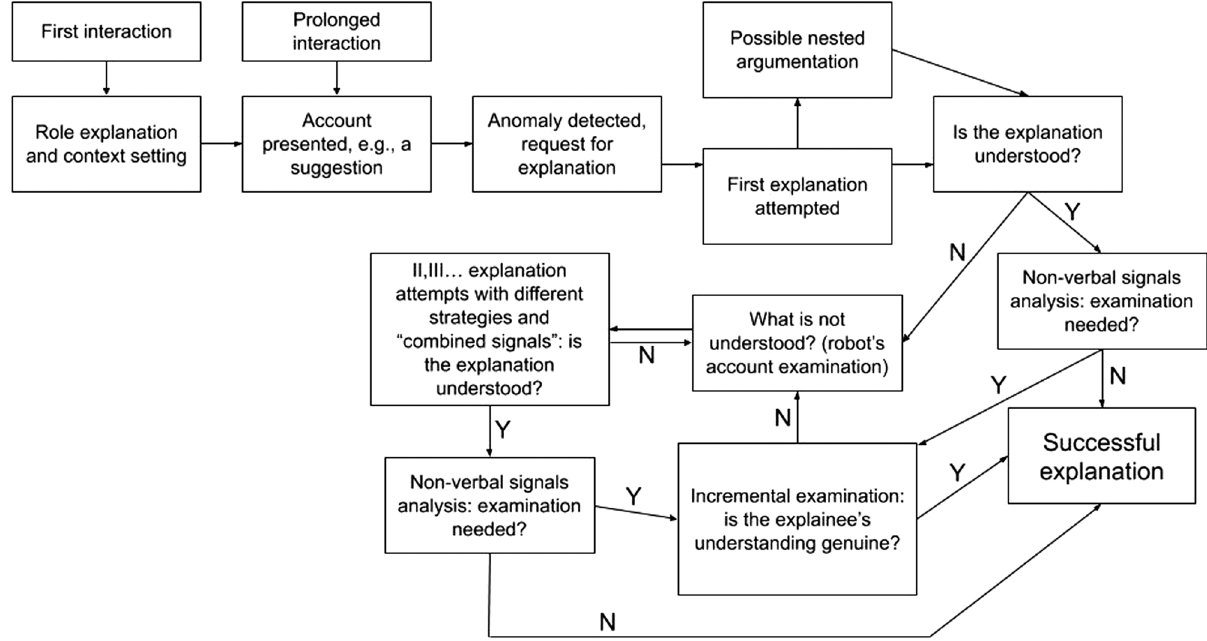
Figure 3: Explanatory dialogue